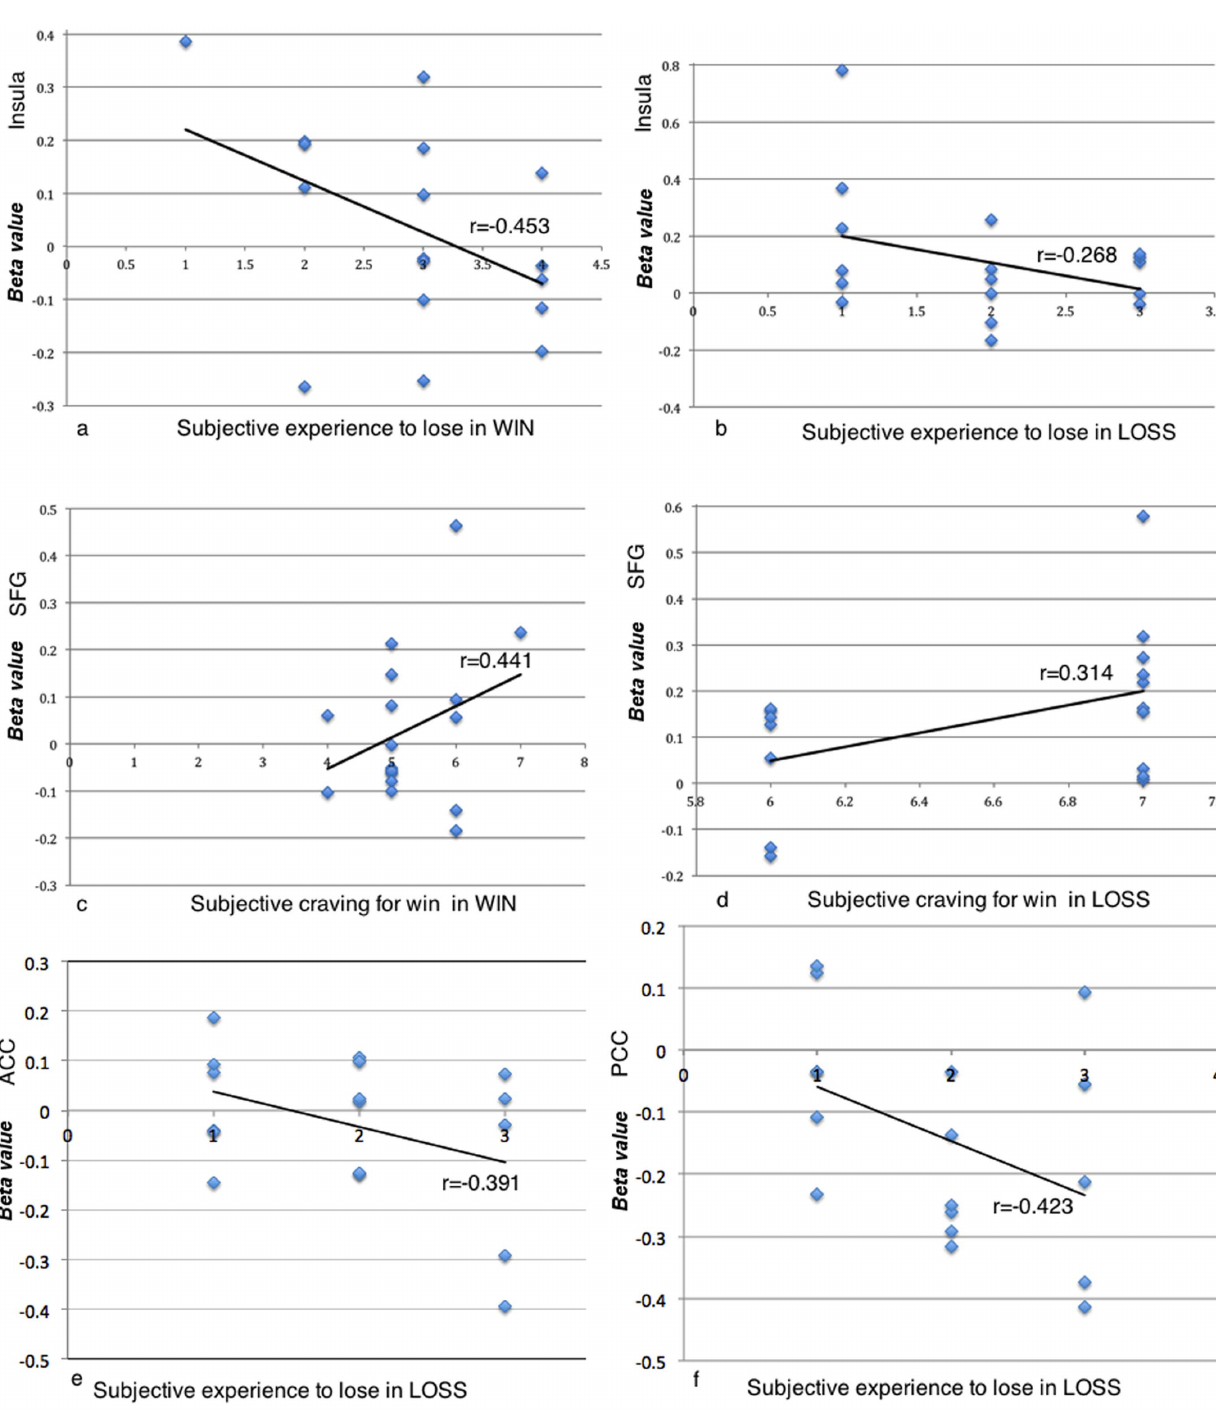
found in other comparisons (WIN-TIE, LOSS-WIN). Beta figure